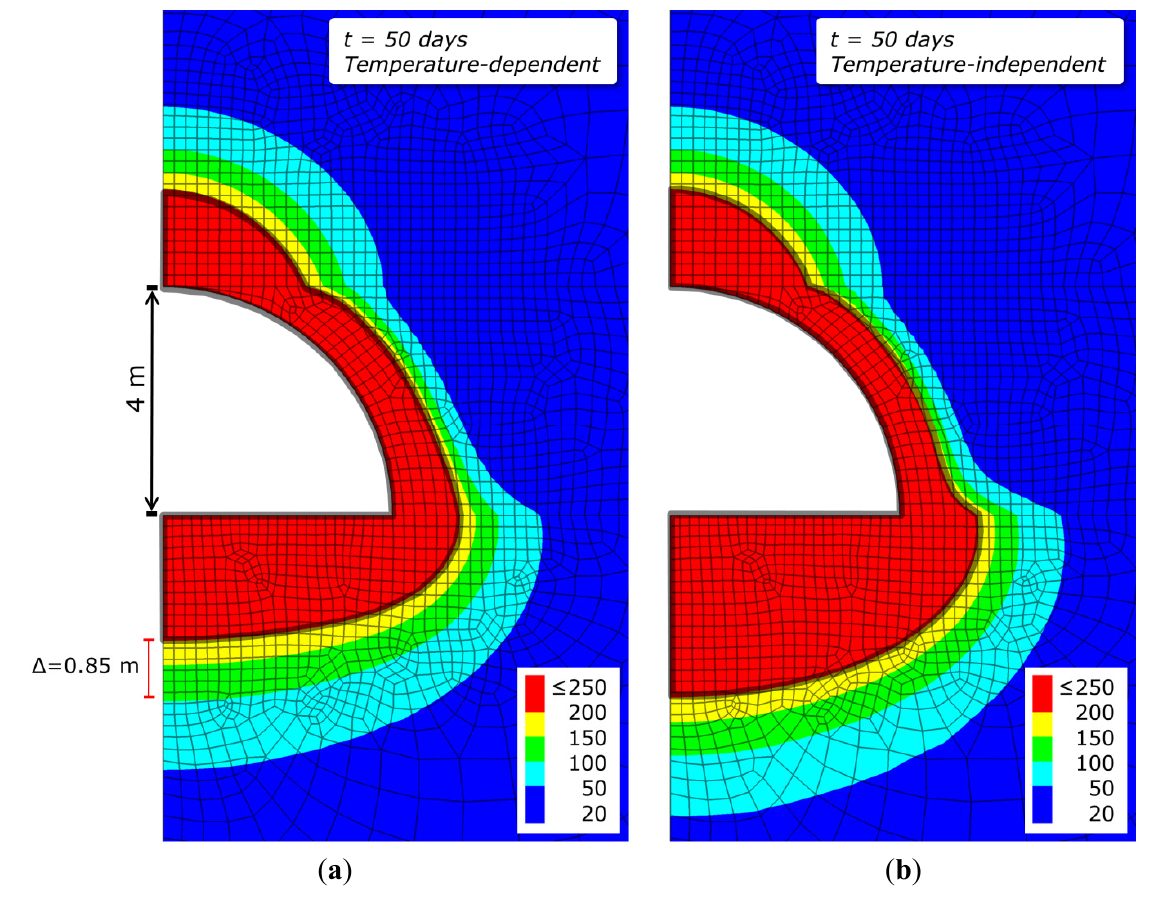
Figure 6. Temperature distribution in the reactor vicinity after 50 days of simulation with ( a ) temperature dependent and ( b ) temperature-independent material properties. The grey solid line represents the 200 °C